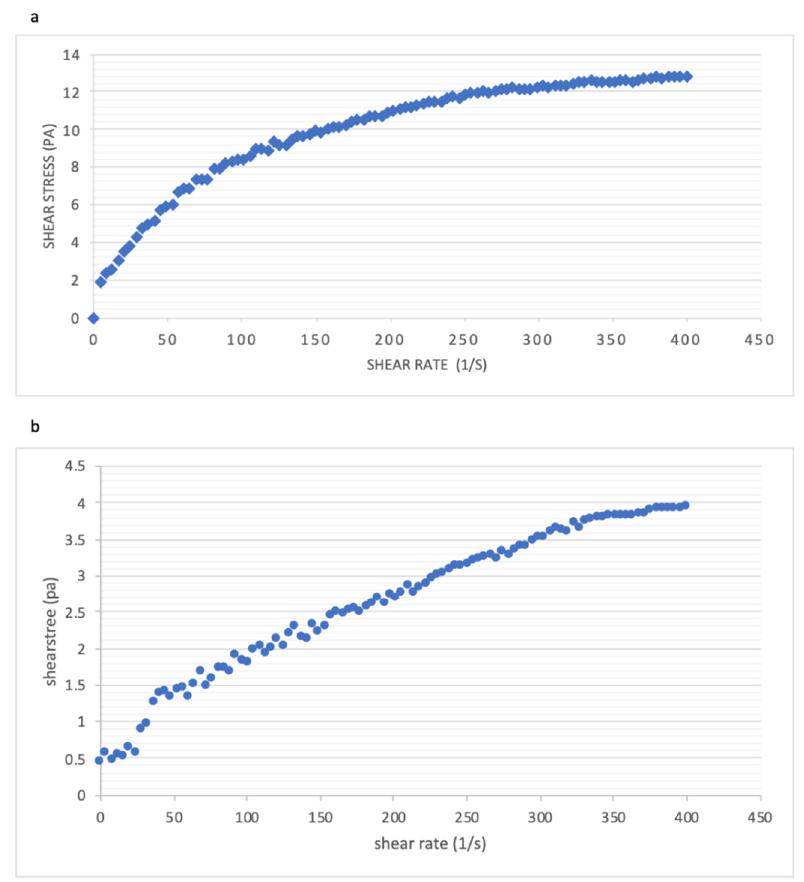
Figure 3. Shear stress against shear rate measured in milk inoculated with: ( a ) the control strain (42 (42 ◦ C) and ( b ) the thermo-tolerant strain (52 ◦ °C) and ( b ) the thermo-tolerant strain (52 °C).